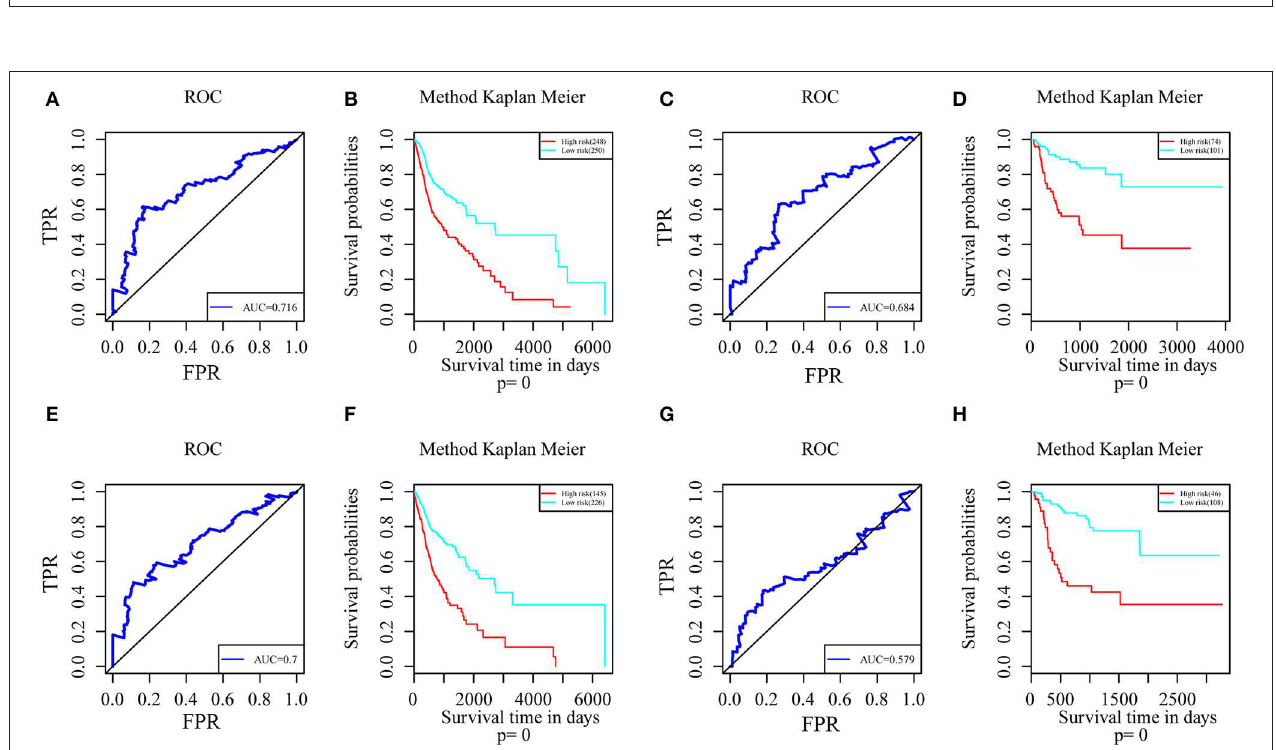
FIGURE 6 | ROC curves and Kaplan-Meier plots of prognostic predictors for seven potential feature genes in HNSCC patients. (A) ROC curves with overall survival AUCs of prognostic predictors plotted for transcriptional events in HNSCC. (B) Kaplan-Meier curves with overall survival of prognostic predictor plotted for transcriptional events in HNSCC. (C) ROC curves with overall survival AUCs of prognostic predictors plotted for AS events in HNSCC. (D) Kaplan-Meier curves with overall survival of prognostic predictor plotted for AS events in HNSCC. (E) ROC curves with recurrence AUCs of prognostic predictors plotted for AS events in HNSCC. (F) Kaplan-Meier curves with recurrence of prognostic predictor plotted for AS events in HNSCC. (G) ROC curves with recurrence AUCs of prognostic predictors plotted for AS events in HNSCC. (H) Kaplan-Meier curves with recurrence of prognostic predictor plotted for AS events in HNSCC.